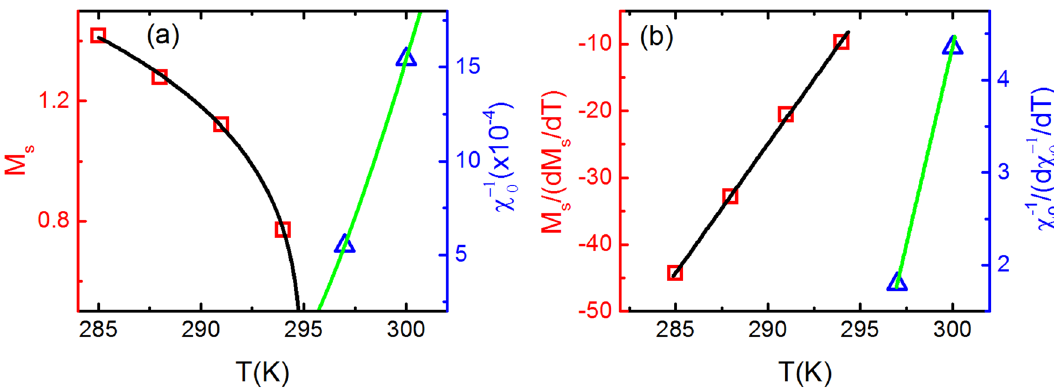
1 0 versus T plot while solid curve is its